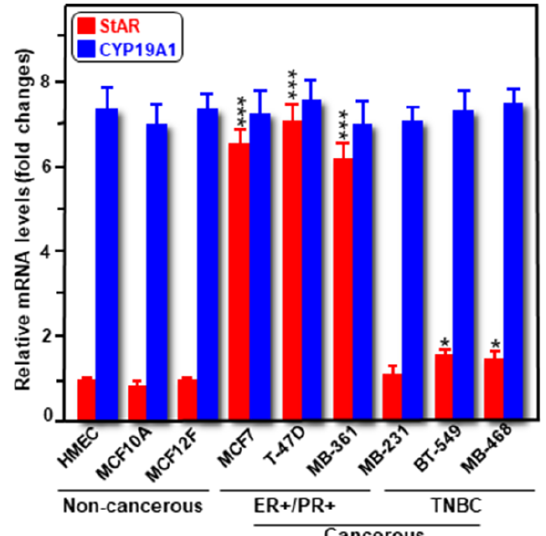
Figure 1. Relative expression of StAR and CYP19A1 mRNAs in human non-cancerous (HMEC, MCF10A, and MCF12F), and cancerous hormone-dependent (MCF7, MDA-MB-361, and T-47D), and hormone-independent (MDA-MB-468, MDA-MB-231, and BT-549) breast cell lines. These cells were cultured with appropriate media and harvested at ~80% confluence, as described under Materials and methods . Cells were processed for RNA extraction using PureLink RNA mini kit, and StAR and CYP19A1 mRNA levels were determined by RT-qPCR and reported as fold changes over non- cancerous cells (considered as 1). Results represent the mean ± SE of three to four independent experiments. *, p < 0.05; ***, p < 0.001 vs. non-cancerous cells.